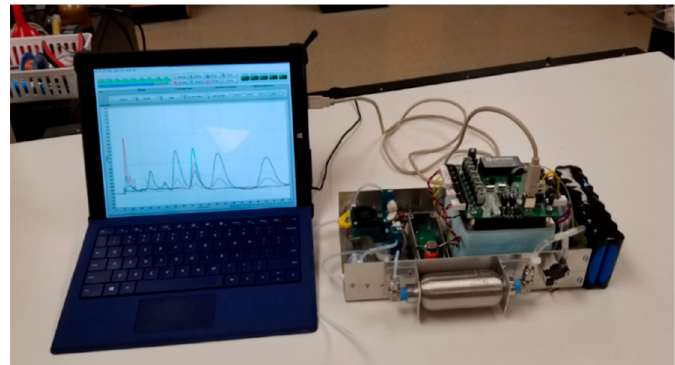
Figure 3. Table-top multisensory gas chromatography (MGC) experimental setup. ChemEngineering 2019 , 3 , x FOR PEER REVIEW